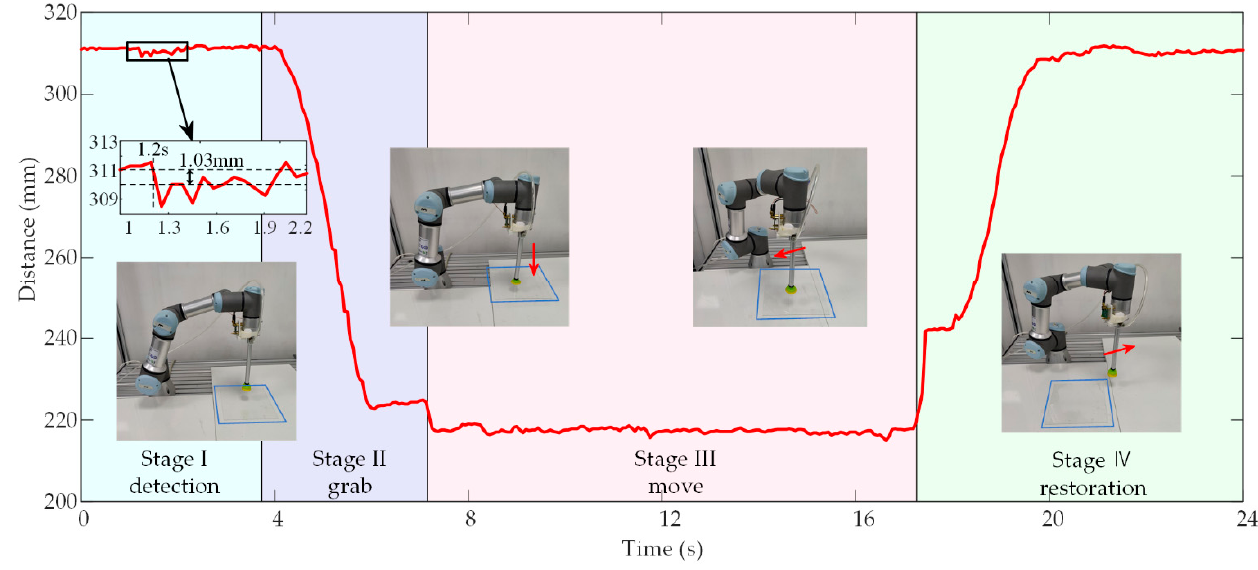
Figure 12. Detection results of the proposed system in comprehensive experiments.